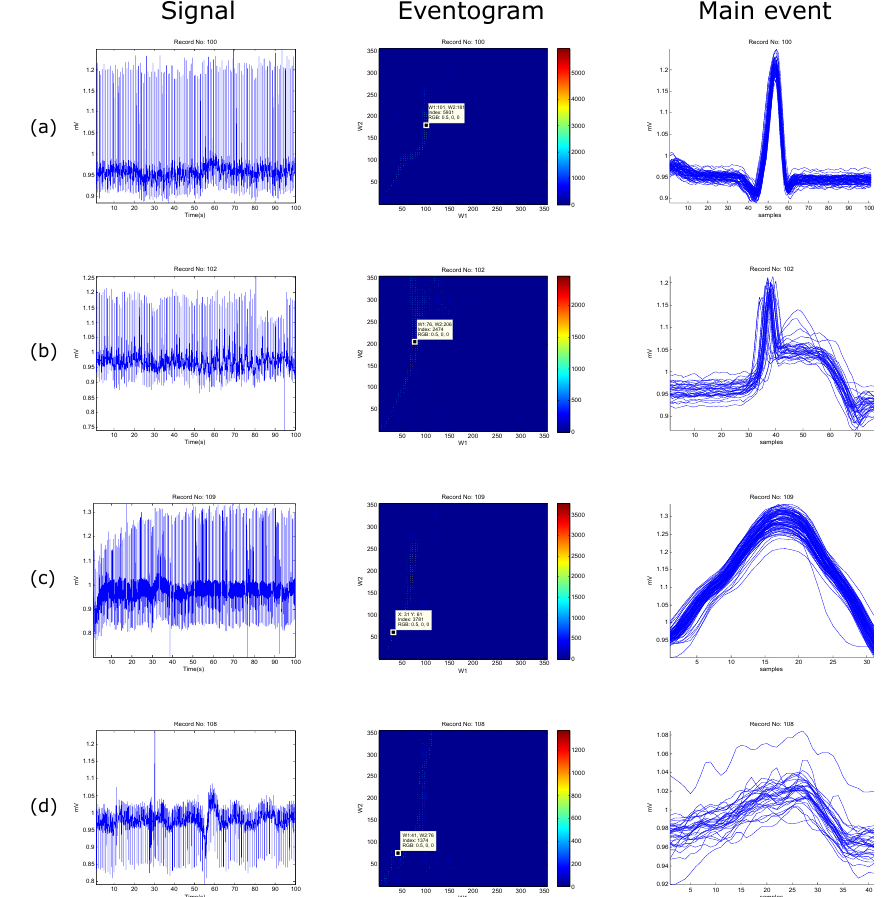
Figure 8. Examples of eventogram output using ECG signals. ( a ) normal beats; ( b ) paced beats; ( c ) left bundle branch block beats; and ( d ) noisy ECG signal. The red color indicates strong dominance of a main event while the blue color indicates non-existence of a main event. The eventogram is stored as a two-dimensional ( W 1 -by- W 2 ) array of integers in the range [1, length(colormap)]; colormap is a W 1 -by-3 matrix of real numbers between 0.0 and 1.0. The eventogram returns the index value in terms of W 1 and W 2 for the most dominant event that is associated with the red color or RGB